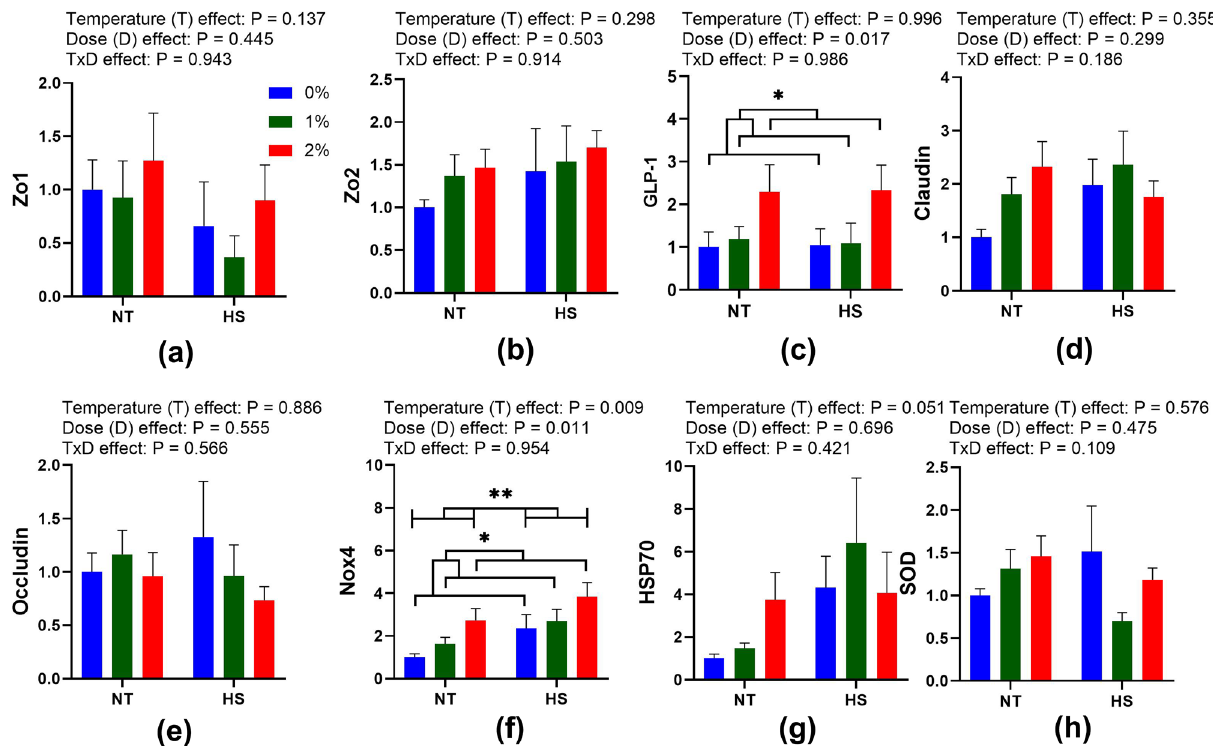
Figure 1. Effect of dietary steam-exploded pine particle supplementation on the gene expression profiling of genes ( a ) Zo1 ( b ) Zo2 ( c ) GLP-2 ( d ) Claudin ( e ) Occludin ( f ) Nox4 ( g ) Hsp70 ( h ) and SOD respectively, in the duodenum of broilers reared under normal or cyclic heat stress conditions. Dietary treatments were 0, 1, and 2% SPP in diets respectively. The temperature of the rooms was maintained at either thermoneutral (NT; 21 °C) or cyclic heat stress (CHS; 31 °C; 6 h daily) for seven